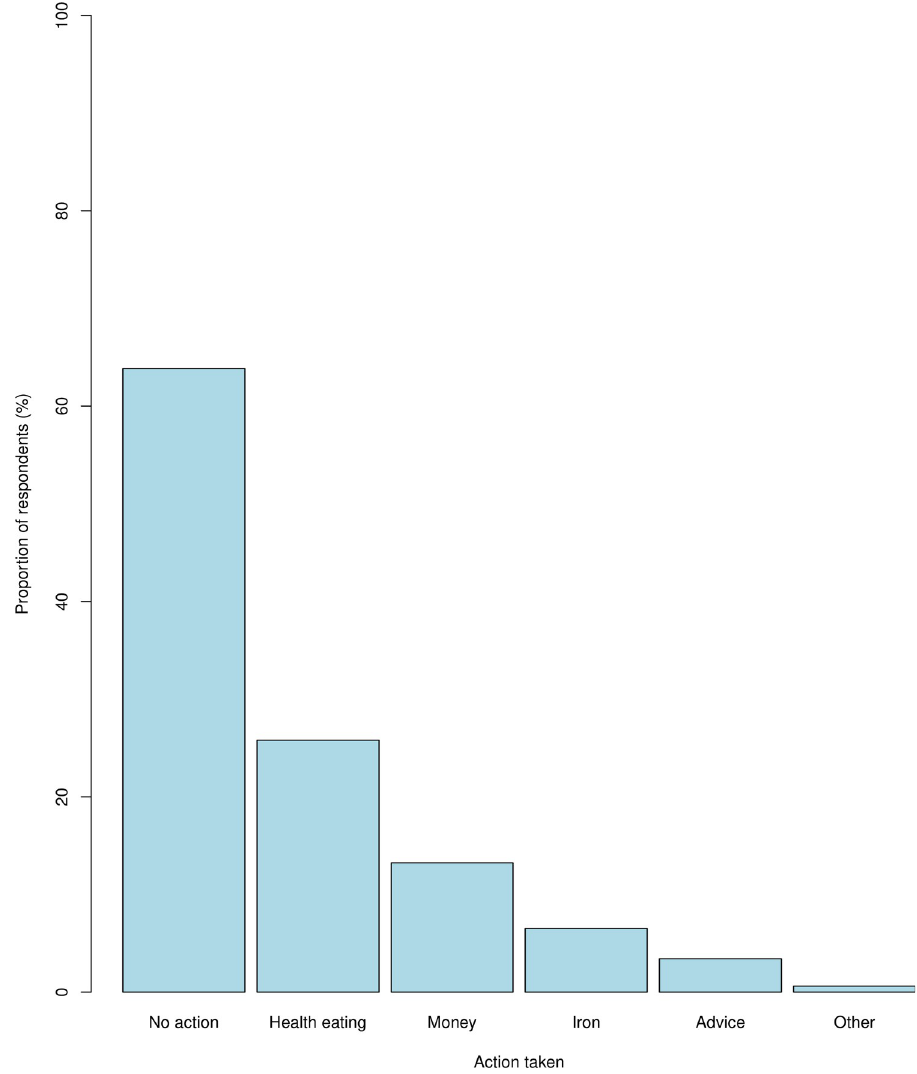
Fig 1. Frequency distribution of actions which pregnant women in Mchinji District, Malawi, took at preconception in preparation for their